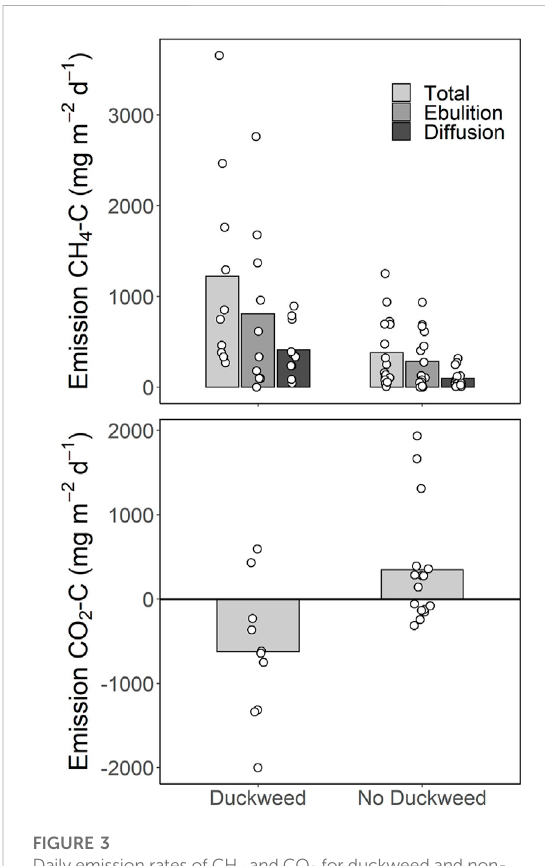
FIGURE 3 Daily emission rates of CH 4 and CO 2 for duckweed and non- duckweed ponds. Signi fi cant differences between duckweed ponds and non-duckweed ponds are total CH 4 emission ( p = 0.04),diffusionCH